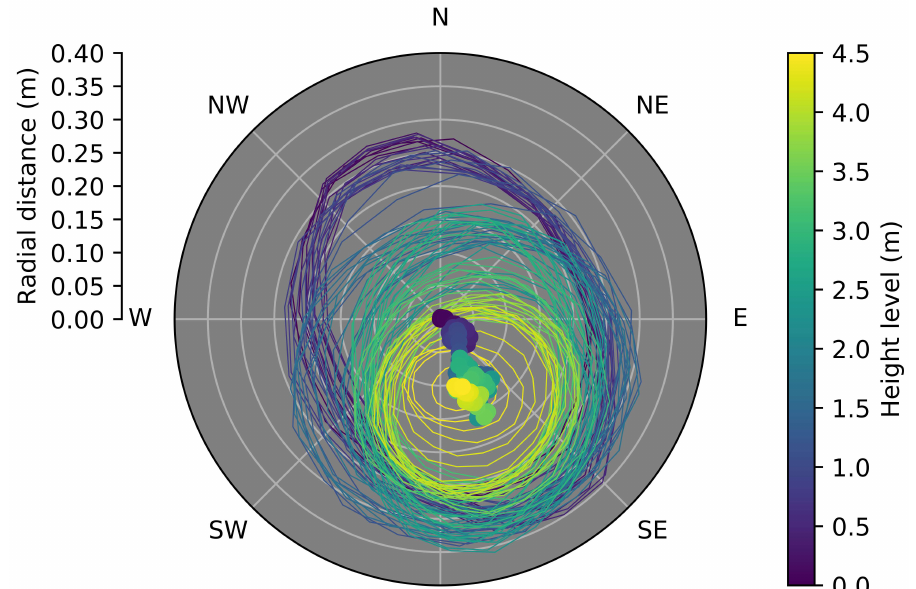
Figure 8. Polar plot of the position of the centers of elliptical cross-sections (colored dots) corresponding to a specific height level (color map). The ellipses represent each elliptical cross-section (5 cm spacing). The shape of the sections (vertically separated by 5 cm) varies from strong elliptical to almost circular. The major on minor axis report (a / b) ranges from 1.65 (ellipse) to 1.02 (circle) with a clear trend from the base to the summit (Figure